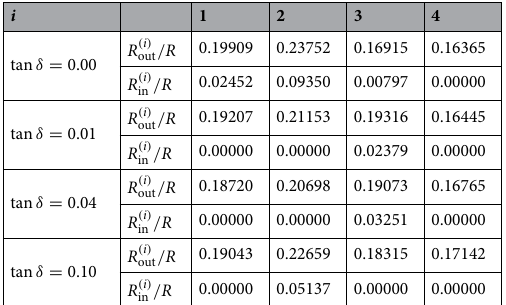
Table 2. Optimized radii of the rubber-lead rods for various tan δ .